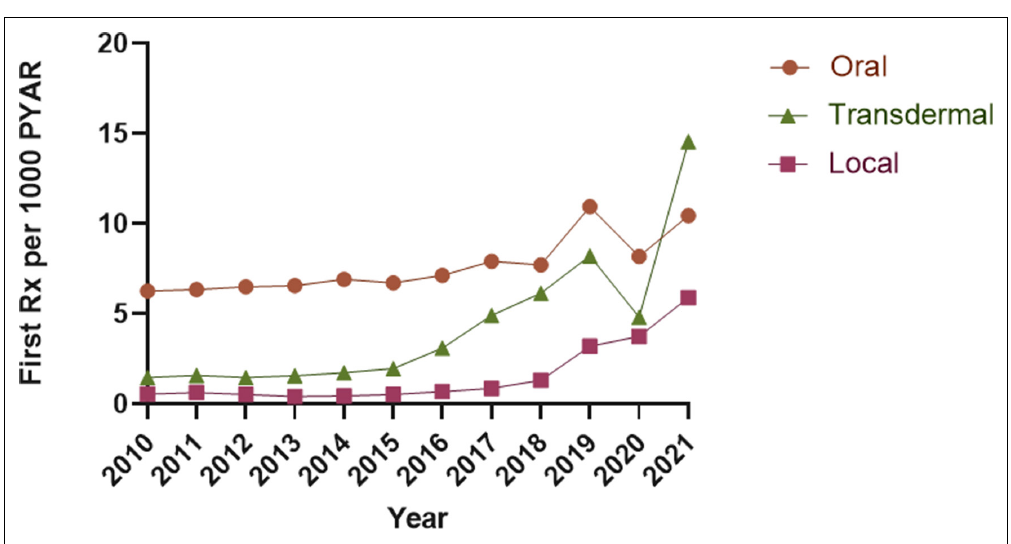
Figure 3 Annual incidence rate of prescribing of HRT medicines by route of administration. HRT = hormone replacement therapy. PYAR = person- year- at- risk. Rx =